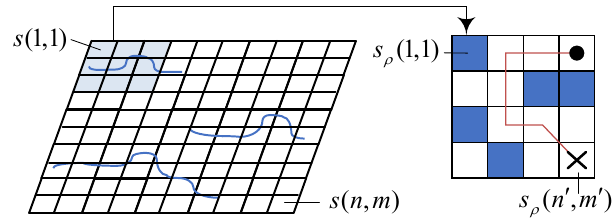
Figure 6. Schematic diagram of map